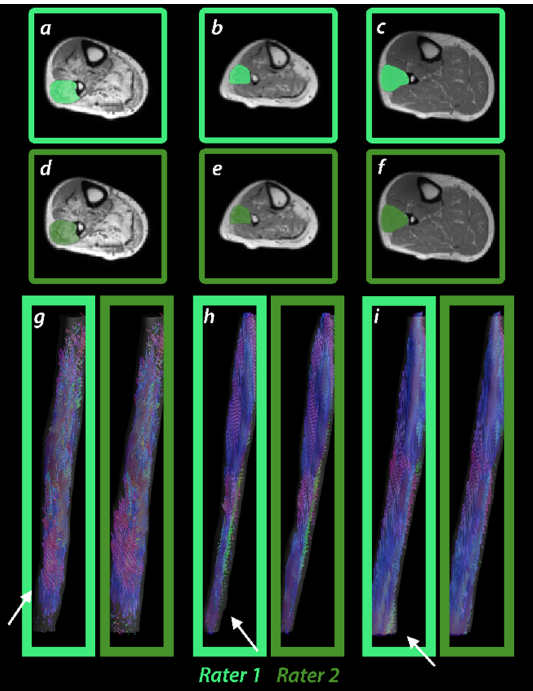
Figure 3. Segmentation of peroneal muscle group and tractography results for different raters in patients with LGMD ( a , d , g ), IBM ( b , e , h ), and a healthy control ( c , f , i ). SNR of diffusion images was good for healthy controls (59.4 ± 16.9) and NMD group (58.1 ± 20.2) [19]. Fat fraction in NMD varied from 0.03 to 0.78 (mean: 0.16 ± 0.15). Mean FA values were 0.22 ± 0.03 for MSB and 0.21 ± 0.03 for VBT in both healthy control and NMD group. In contrast, mean MD values were lower in NMD group (MSB: 1.54 ±